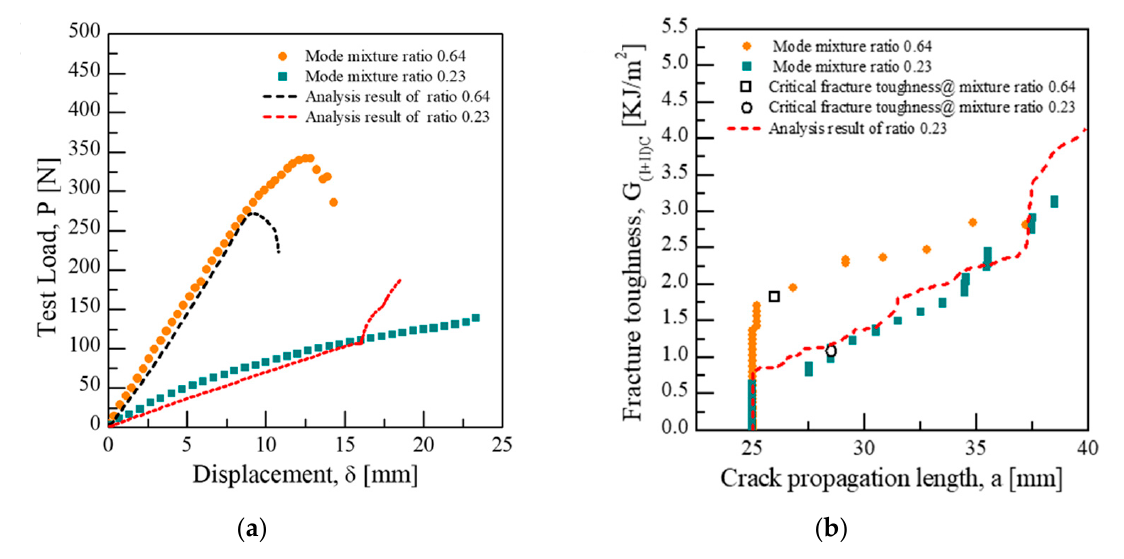
Figure 16. Comparative analysis of specimen-level FE analysis results and Mixed-mode test results: